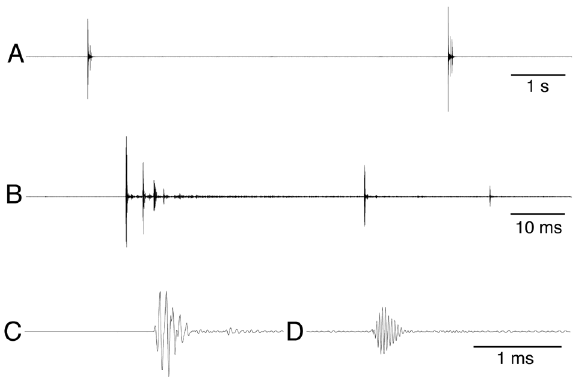
Figure 51. Oscillogram of the calling song of Morgenia leh - mannorum sp. n. at different time scales. A two syllables with an unusually short inter-syllable interval B complete syllable C first impulse of syllable D pulse-like middle